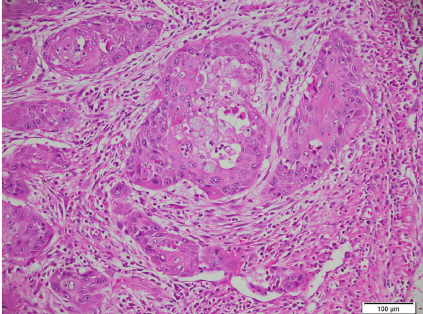
Figure 7: Histopathology revealed carcinoma with squamous dif- ferentiation and some admixed tumour cells containing intracyto- plasmic mucin.